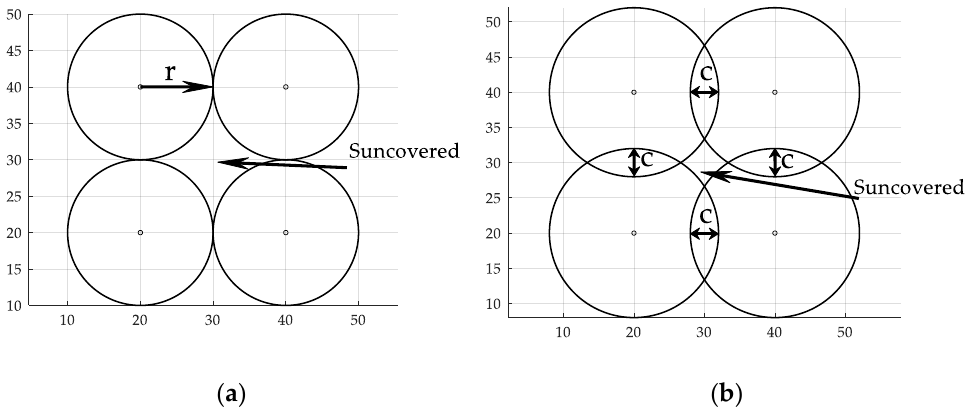
Figure 1. Territory coverage with four sensors: without intersection level ( a ); with intersection level ( b ).